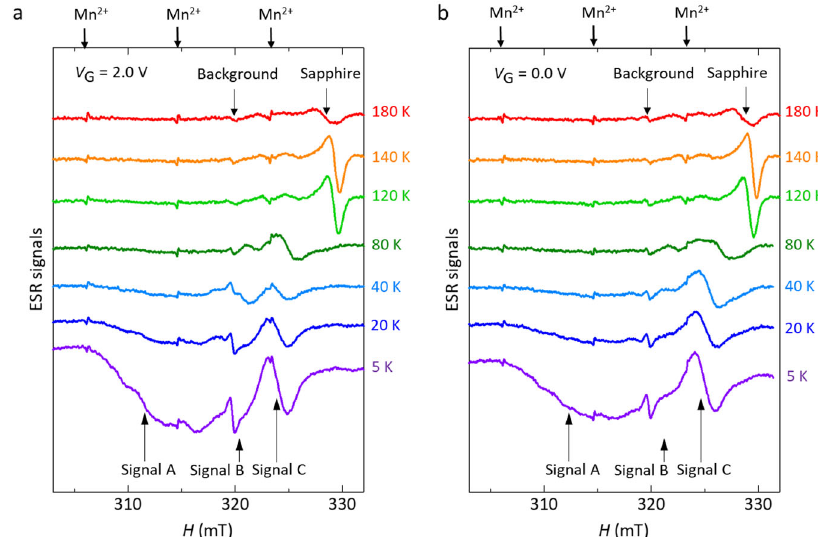
Fig. 2 Temperature and gate-voltage dependence of ESR spectra of the MoS 2 transistor. a ESR spectra measured at a gate voltage ( V G ) of V G ¼ 2 V and a drain voltage ( V D ) of V D = 1 V. b ESR spectra measured at V G ¼ 0 V and V D = 1 V. Distortion of the baseline of the spectra at low temperatures, typically below 40 K, is due to the background signal of the ESR cavity